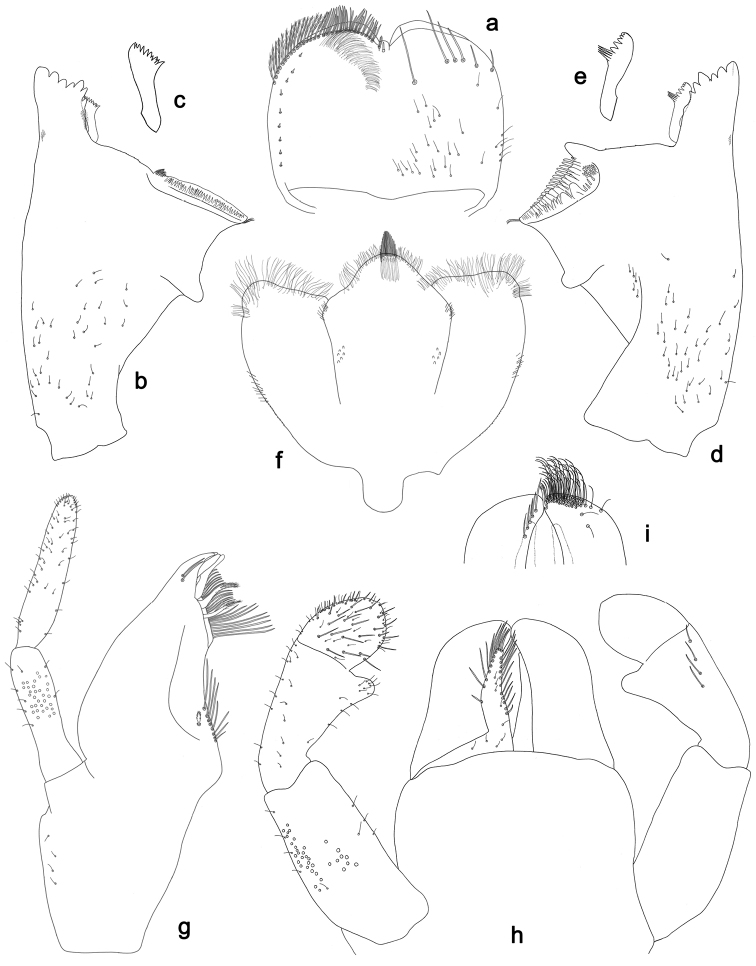
Labiobaetisaltus sp. n., larva morphology: a Labrum b Right mandible c Right prostheca d Left mandible e Left prostheca fHypopharynxg Maxilla h Labium.